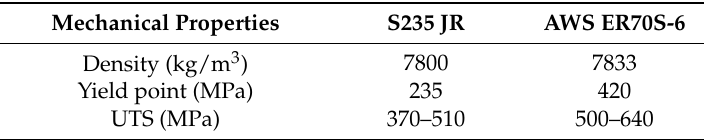
Table 1. Properties of the substrate and the welding wire.